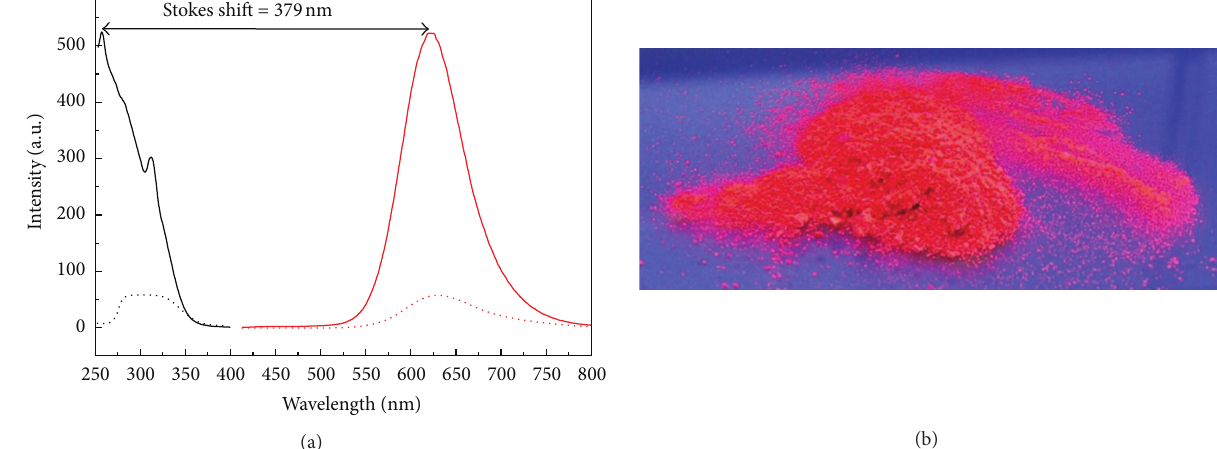
Figure 4: Photoemission spectra (red lines) of the luminescent polymer-embedded Au clusters obtained from linear Au-thiolates: dodecyl- thiolate (dotted line); tetradecyl-thiolate (solid line) (a). Pure gold dodecyl-thiolate powder under UV-light (365nm)